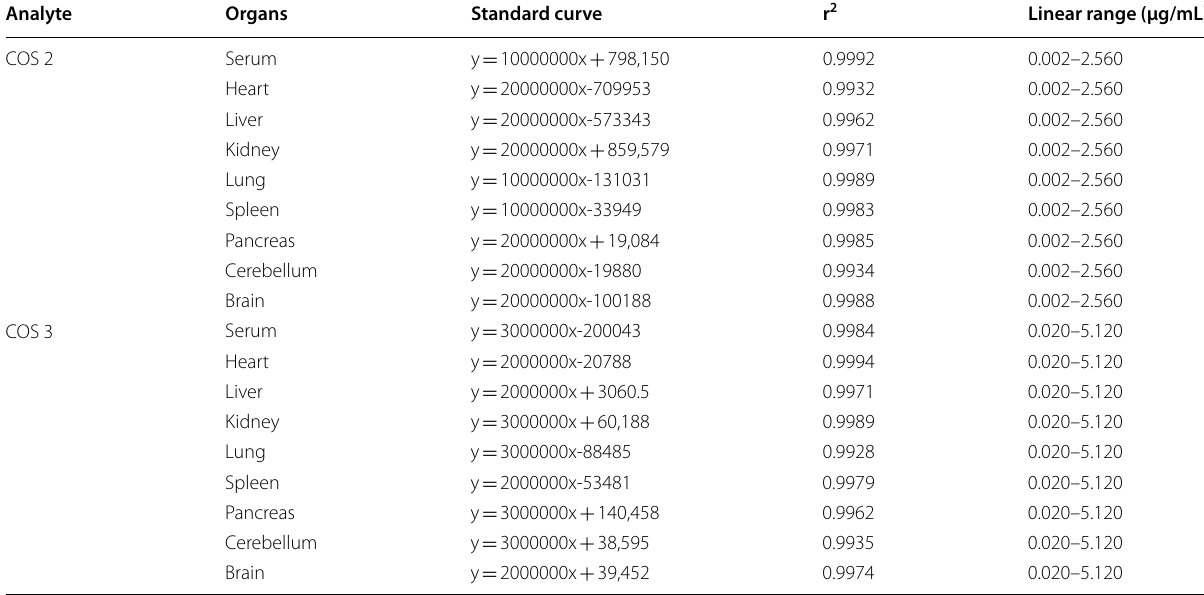
Table 1 The standard curve, linear range, and r 2 of COS 2 and COS 3 in serum and tissues Analyte